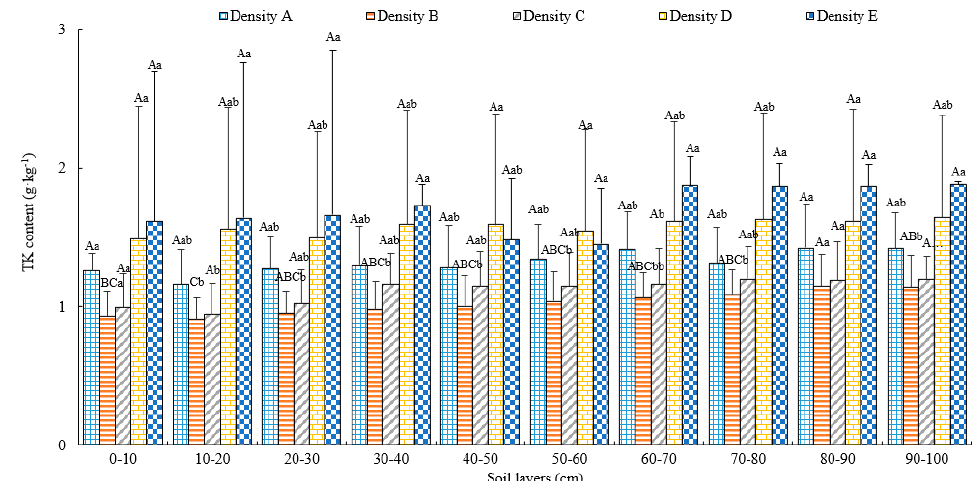
Figure 7. Soil total K in different layers under different stand densities (g·kg − 1 ). Note: different lowercase letters indicate significant differences among different densities at the 0.05 level, and different capital letters of the same density indicate significant differences among different soil layers at the 0.05 level.